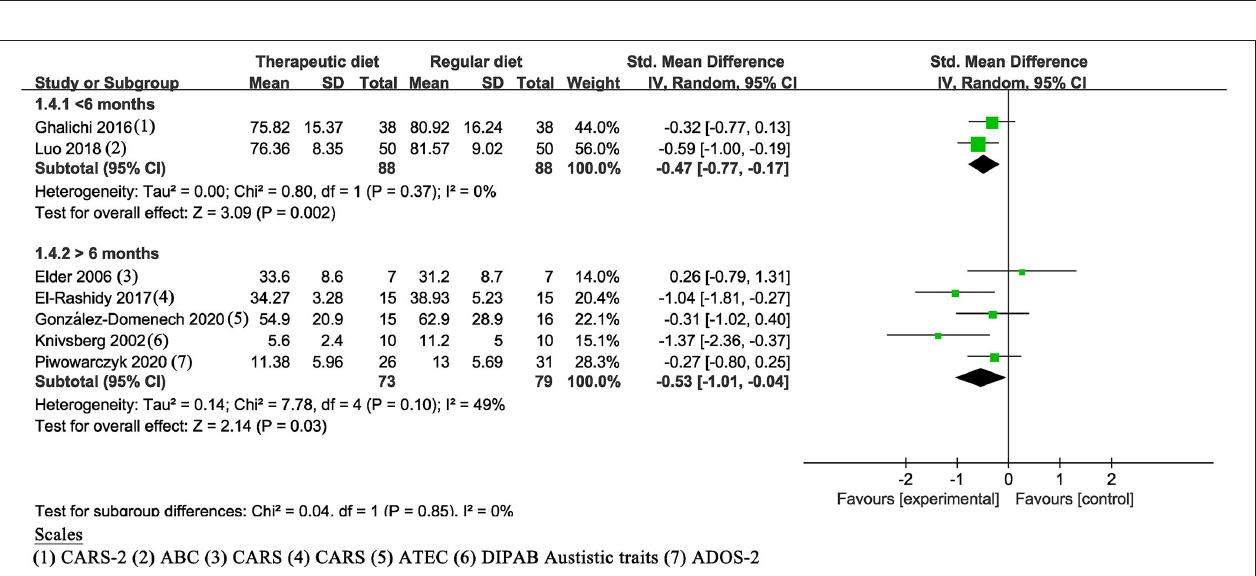
FIGURE 4 | Meta-analysis results and scales for dietary intervention. GFCF, gluten-free and casein-free diet; GFD, gluten-free diet; KD, ketogenic diet; GARS (-2), Gilliam Autism Rating Scale (Second Edition); ATEC, Autism Treatment Evaluation Checklist; DIPAB, a standardized Danish scheme to evaluation behavior; ADOS-2, Autism Diagnostic Observation Schedule, Second Edition; ABC, Autism children behavior checklist.